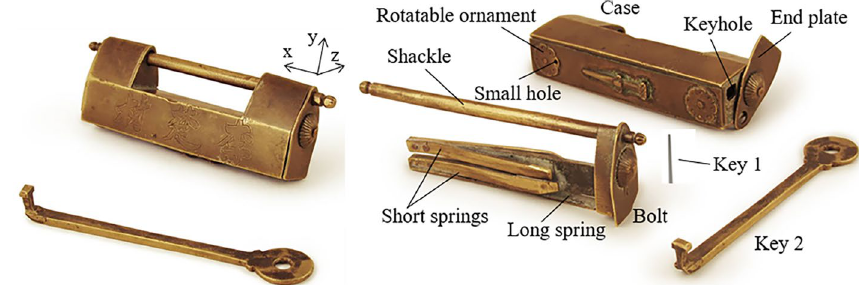
Figure 12. Rotating ornament lock.